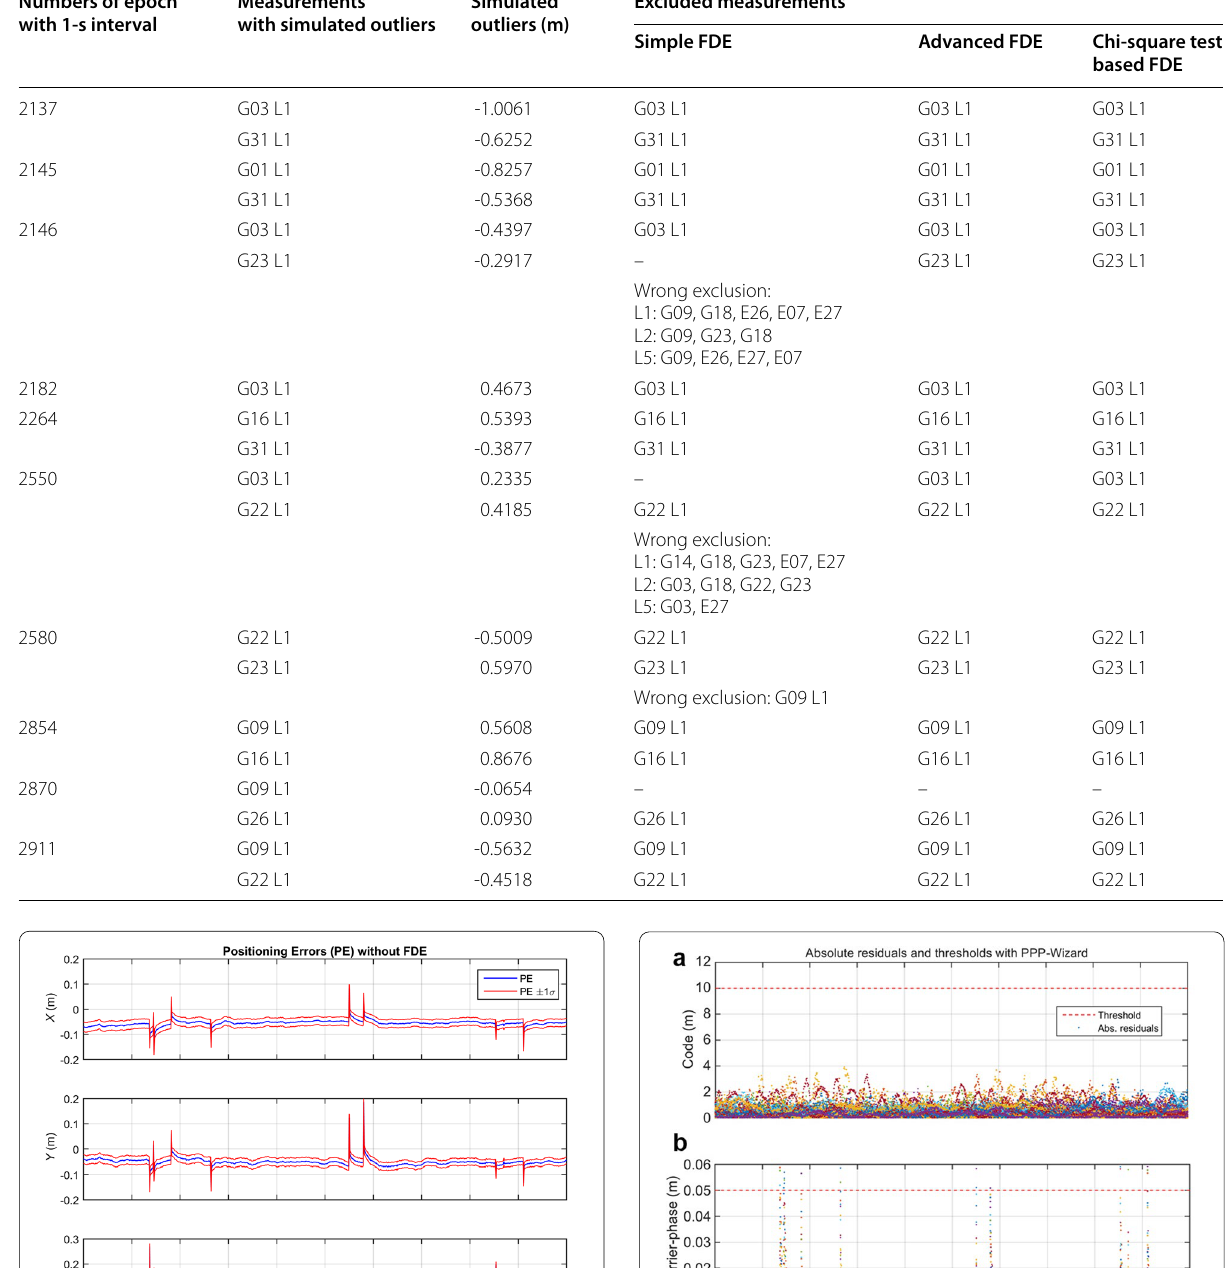
Table 3 Excluded measurements with different FDE methods compared with simulated faults in measurements Numbers of epoch with 1‑s interval